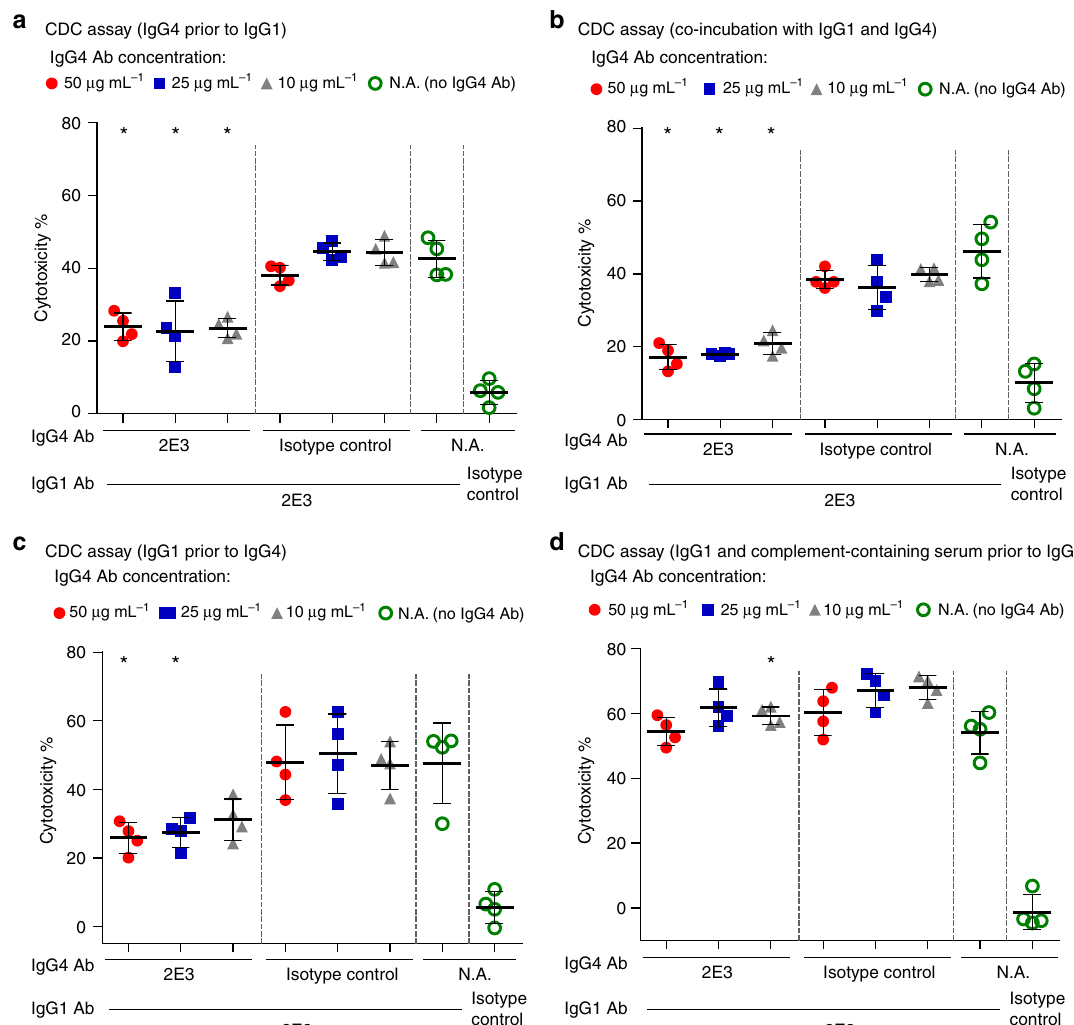
Fig. 5 Inhibition of IgG1-induced CDC by IgG4. a CDC when target cells were sequentially incubated with IgG4 antibodies for 1 h, then IgG1 antibodies for 1 h, followed by complement serum for 3 h. b CDC when target cells were coincubated with IgG4 and IgG1 antibodies for 1 h, followed by complement serum for 3 h. c CDC when target cells were sequentially incubated with IgG1 antibodies for 1 h, then IgG4 antibodies for 1 h, followed by complement serum for 3 h. d CDC when target cells were coincubated with IgG1 antibodies and complement serum for 1 h, followed by addition of IgG4 antibodies and incubation for another 2 h. CDC result is represented by target cell cytotoxicity (mean ± s.d., N = 4 independent experiments). * P = 0.0286, two-tailed Mann − Whitney test, compared with respective isotype control. The source data underlying Fig. 5a – d are provided as a Source Data fi le. CDC